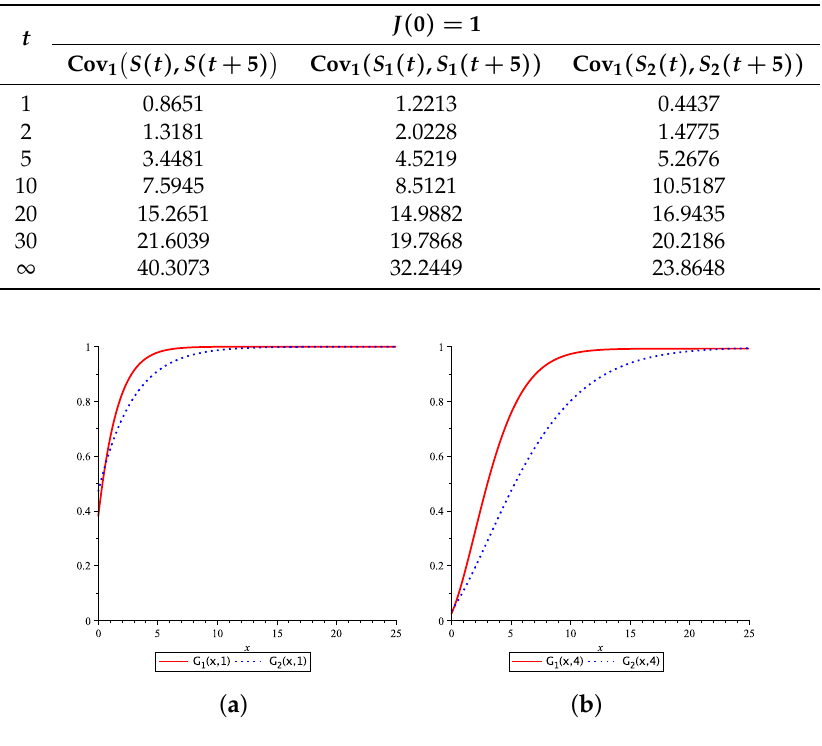
Table 3. Covariances of discounted claims at t and t + 5.